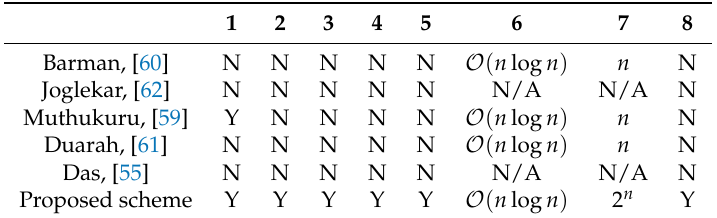
Table 2. Security analysis comparison of proposed scheme and other